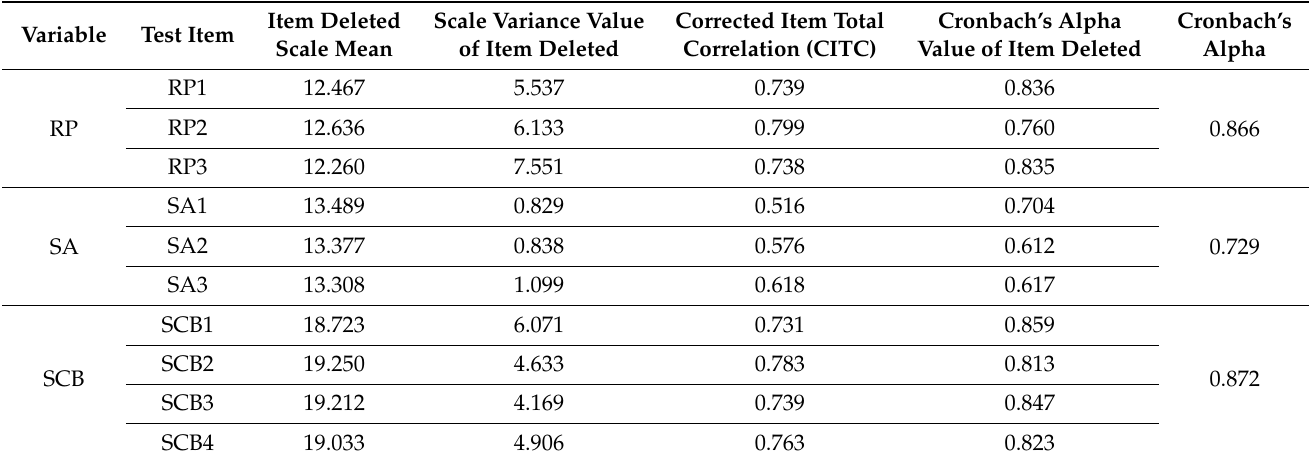
Table 4. Results of reliability analysis of each dimension of the